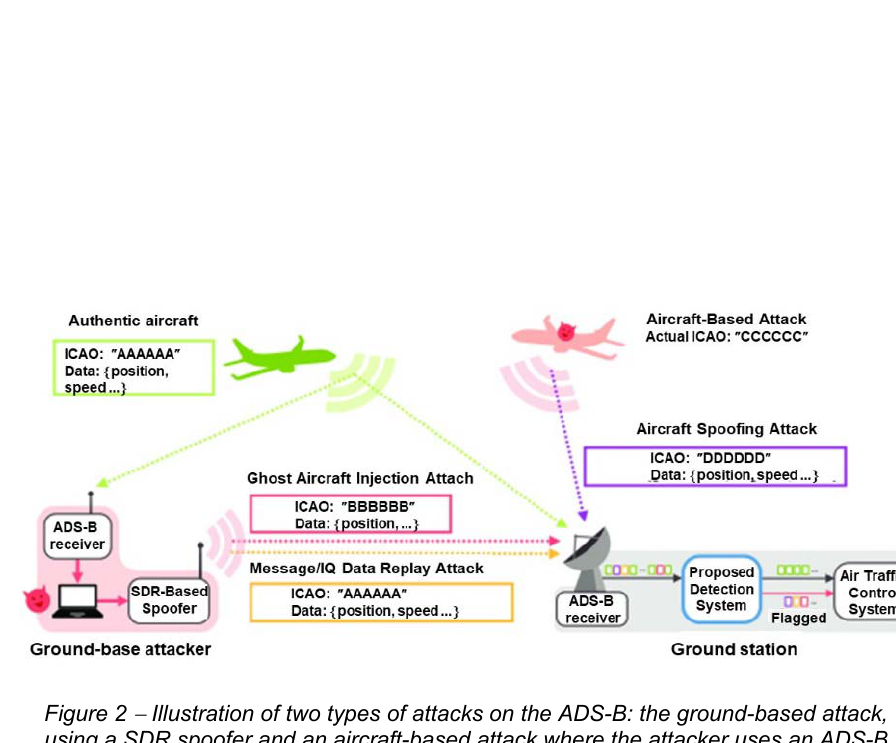
Figure 2  Illustration of two types of attacks on the ADS-B: the ground-based attack, using a SDR spoofer and an aircraft-based attack where the attacker uses an ADS-B transponder with a changed ICAO address (Ying et al, 2019) Рис . 2  Иллюстрация двух типов атаки на ADS-B: наземная атака с использованием спуфера SDR и воздушная атака , при которой злоумышленник использует транспондер ADS-B с измененным адресом ICAO (Ying et al,